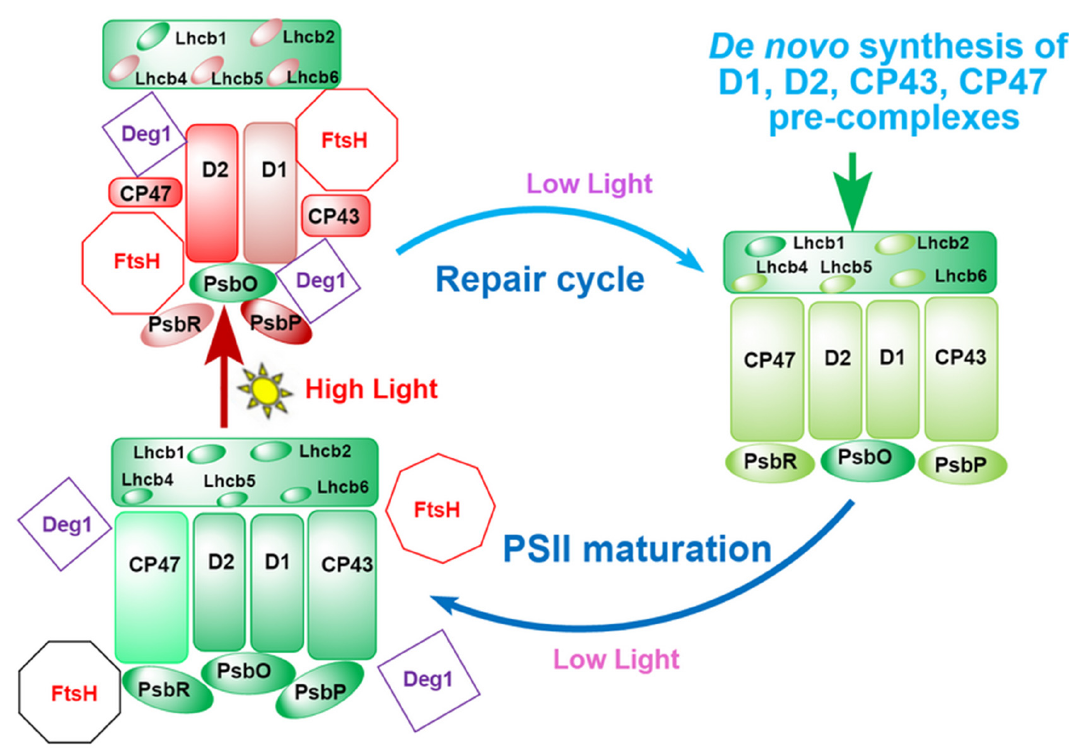
Figure 6. HL-induced disassembly of PSII–LHCII SC and its reassembly under LL conditions in LS albino tea plant.